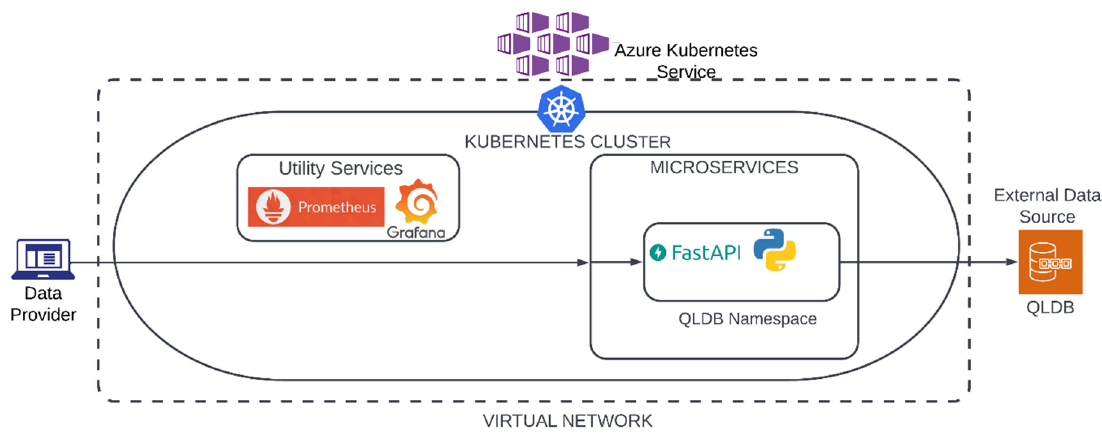
Figure 5. High-level architecture of our prototype interacting with QLDB.